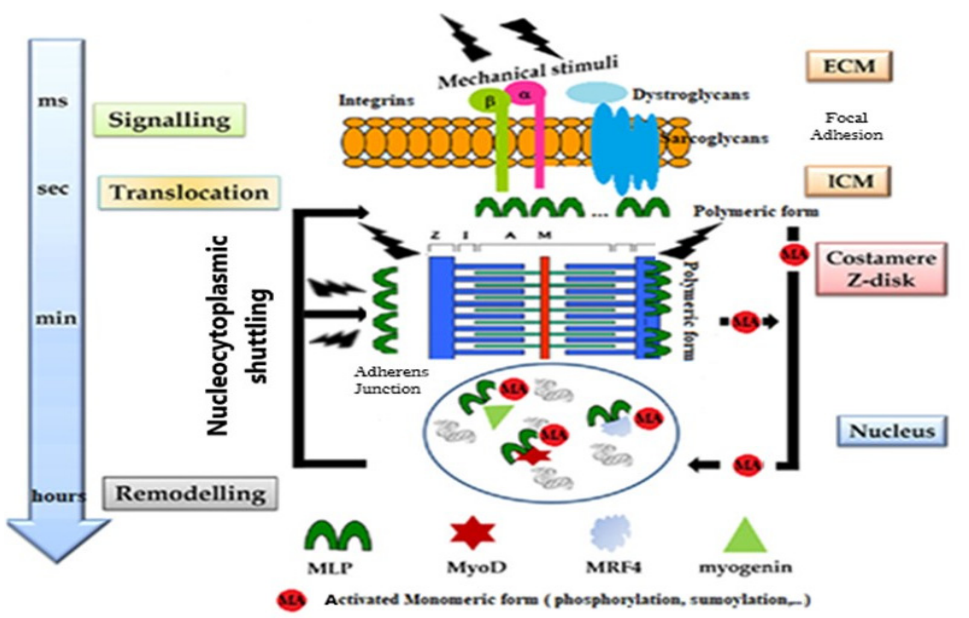
Figure 2. Proposition of events implying the mechanotransduction process induced by MLP following mechanical stimulation. Shown are the different molecular partners that are involved during the cross-talk between the extracellular matrix (ECM) and intracellular matrix (ICM) upon mechanical stimuli. The dual role of MLP as a structural protein in its polymeric form and as a functional protein in its activated monomeric form that plays the role of cofactor of MyoD, MRF4, and myogenin transcription factors. Post-translational modifications as phosphorylation or sumoylation of monomeric MLP triggers its shuttling to the nucleus. Inspired and modified from [9].